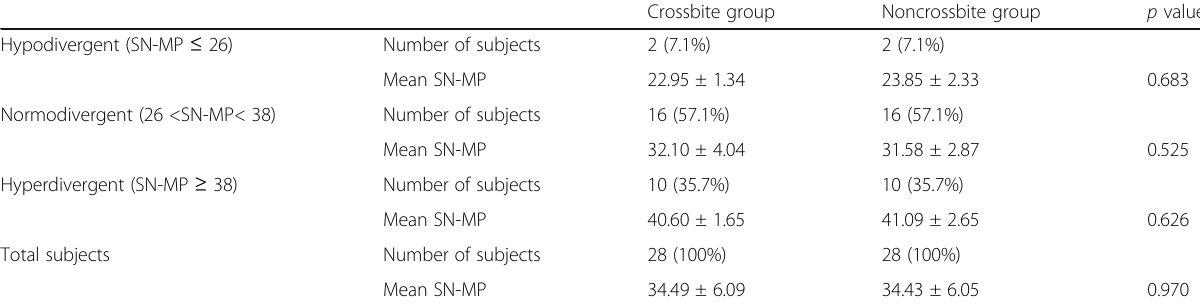
Table 2 Vertical facial type comparison between the crossbite and noncrossbite groups